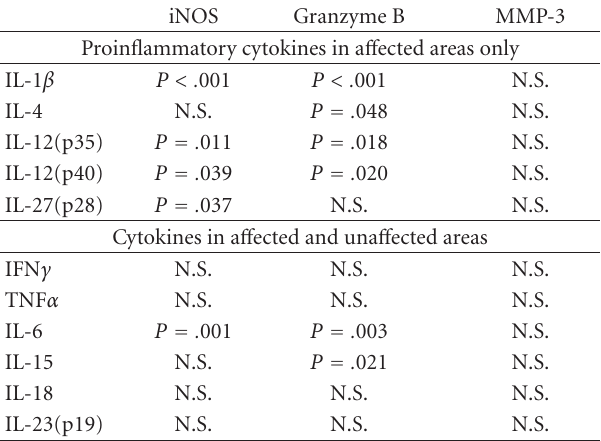
Table 4: Correlation analysis of mRNA levels among cytokines and e ff ector molecules in a ff ected areas from UC (Spearman’s correlation rank).